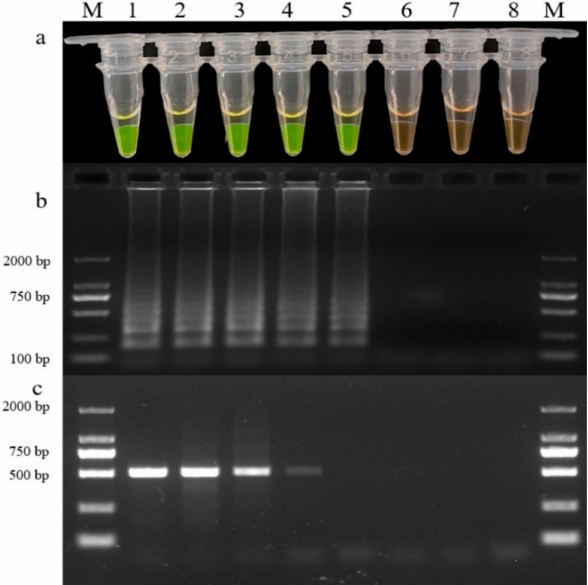
Figure 7. Comparisons of the sensitivity between loop-mediated isothermal amplification (LAMP) and conventional PCR for detecting P. graminea with serial DNA dilutions. Assessments of LAMP reactions based on SYBR Green I visualization of color change ( a ), agarose gel electrophoresis ( b ), and the conventional PCR products from agarose gel electrophoresis ( c ). Lane M, DNA ladder; tubes and lanes 1 to 7, reaction of serial P. graminea genomic DNA dilutions of 1 × 10 2 , 1 × 10 1 , 1 × 10 0 , 1 × 10 − 1 , 1 × 10 − 2 , 1 × 10 − 3 , and 1 × 10 − 4 ng/ µ L, respectively; tube and lane 8, reaction with ddH 2 O (negative